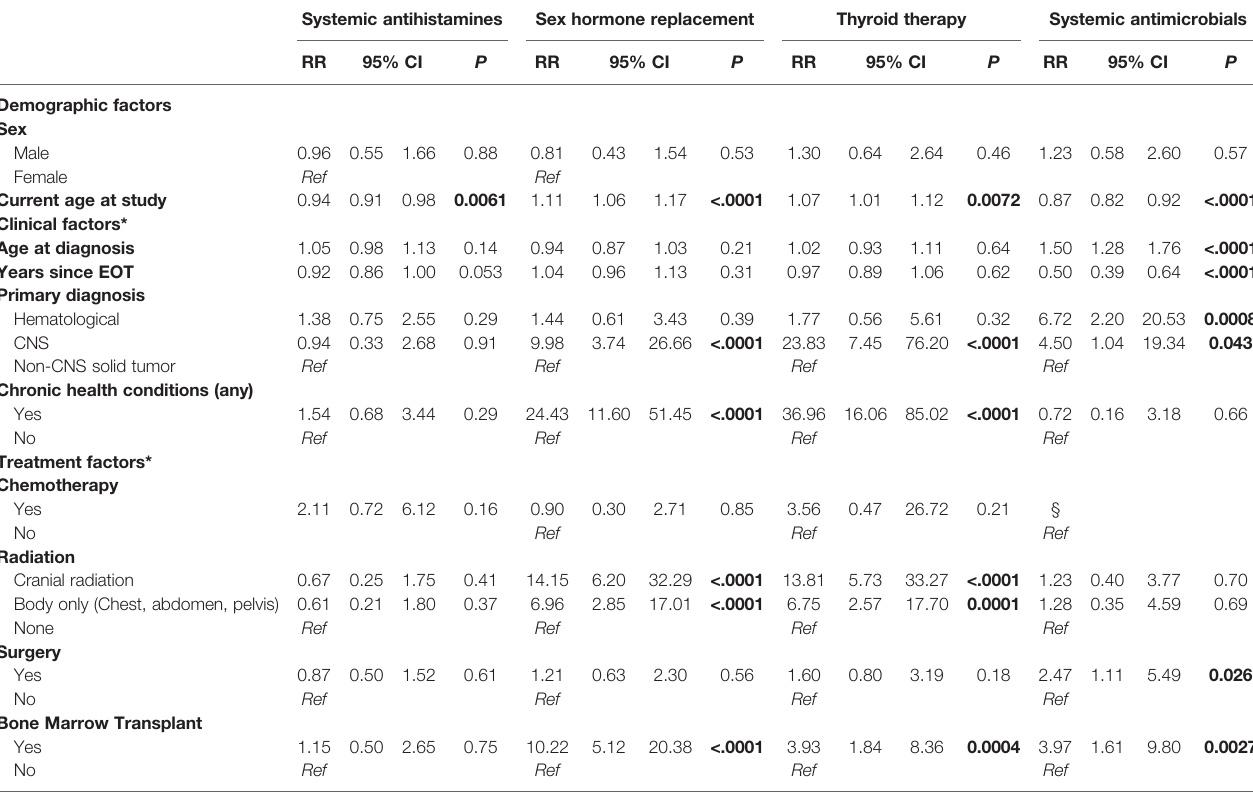
TABLE 4 | Factors associated with speci fi c therapeutic classes of medications. Systemic antihistamines Sex hormone replacement Thyroid therapy Systemic